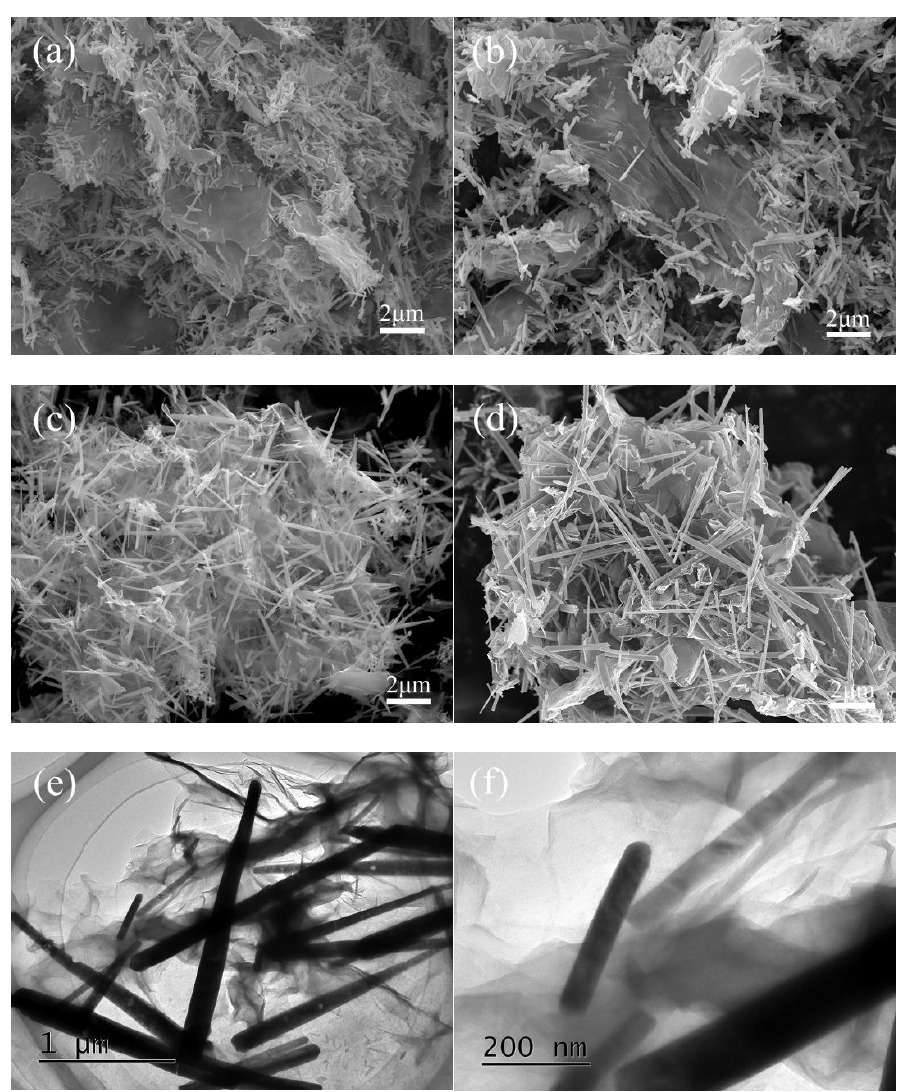
Figure 1. SEM images of Bi 2 S 3 /rGO-1 ( a ), Bi 2 S 3 /rGO-2 ( b ), Bi 2 S 3 /rGO-3 ( c ), Bi 2 S 3 /rGO-4 ( d ); TEM images of Bi 2 S 3 /rGO-3 ( e , f ).